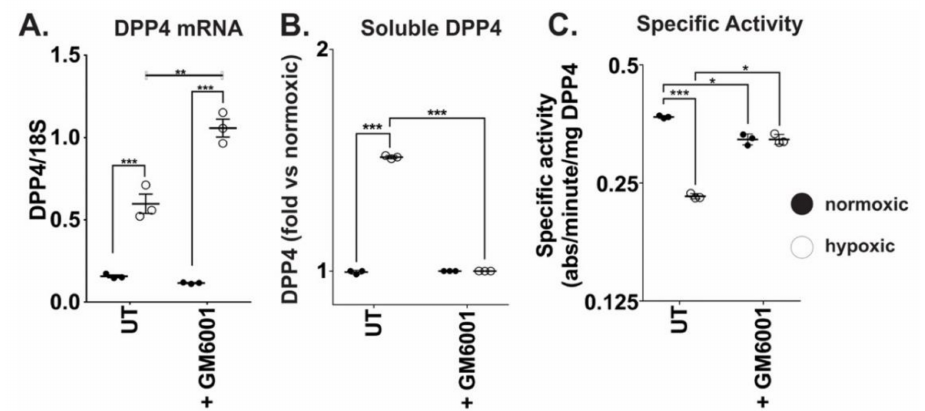
Figure 4. Matrix metalloproteinases (MMP) activity influences DPP4 expression and release in ovarian cancer cells. OVCAR4 cells were treated with the pan-MMP inhibitor GM6001 (25 µ M) and cultured under normoxia or hypoxia for 48 h. Cells were harvested and analysed for ( A ) DPP4 mRNA expression; and conditioned media were collected and analysed for ( B ) soluble DPP4 protein abundance and ( C ) DPP4 enzyme activity. The data represent the mean ± SD, n = 3 / group. * p < 0.05; ** p < 0.01; *** p < 0.001.